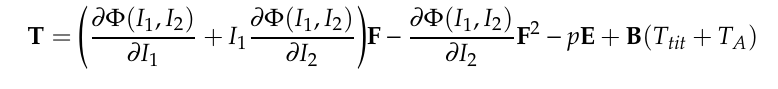
Table S1: Parameters of the myocardium cell model, Table S2: LV shape approximation parameters, Table S3: Parameters of the hemodynamic model, Table S4: Values of the parameters for the regulation block of the myocardium cell-model for the simulation of HCM- and DCM-associated mutations, Table S5: Geometrical parameters of the normal LV and the LVs with cardiomyopathy. Video S1: Animation of the changes in the shape and sarcomere lengths during the simulation of a heartbeat. Left to right: the normal, HCM, and DCM LV models. The animation starts with the atrial systole. The color code is for sarcomere length in µ m. Author Contributions: Conceptualization, F.S. and A.T.; software, F.S. and A.K.; validation, F.S.; investigation, numerical simulations and the results analysis, F.S., A.K. and A.O.; visualization—A.K. and A.O., writing—original draft preparation, F.S.; writing—review and editing, A.K., A.O. and A.T.; supervision, A.T. All authors have read and agreed to the published version of the